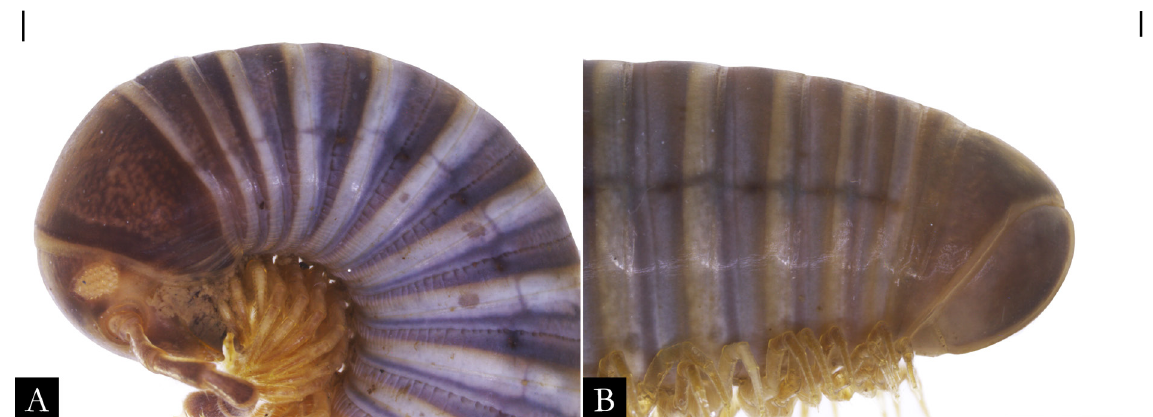
Fig. 155. Pseudonannolene insularis sp. nov., paratype, ♀ (IBSP 1231), in lateral view. A . Anterior region. B . Posterior region. Scale bars = 0.2